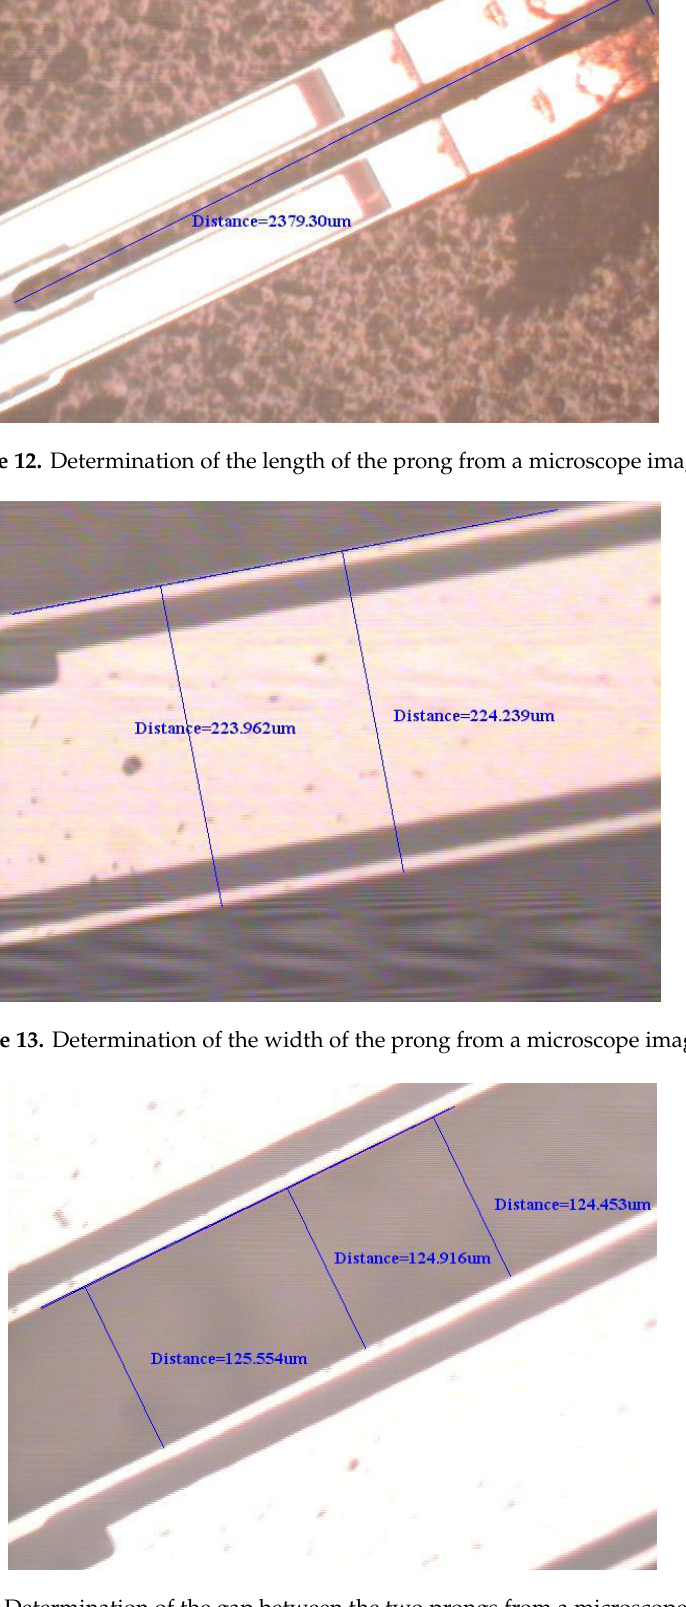
Figure 15. Determination of the width of the proof mass from a microscope image.